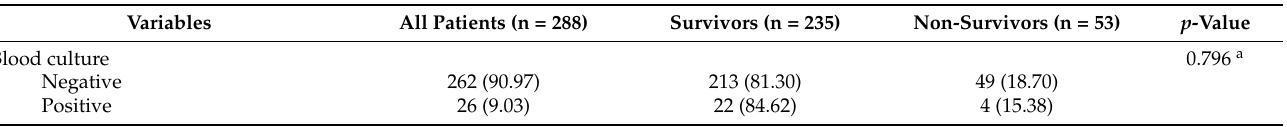
Table 2. Laboratory characteristics, treatment, and comparison of surviving and